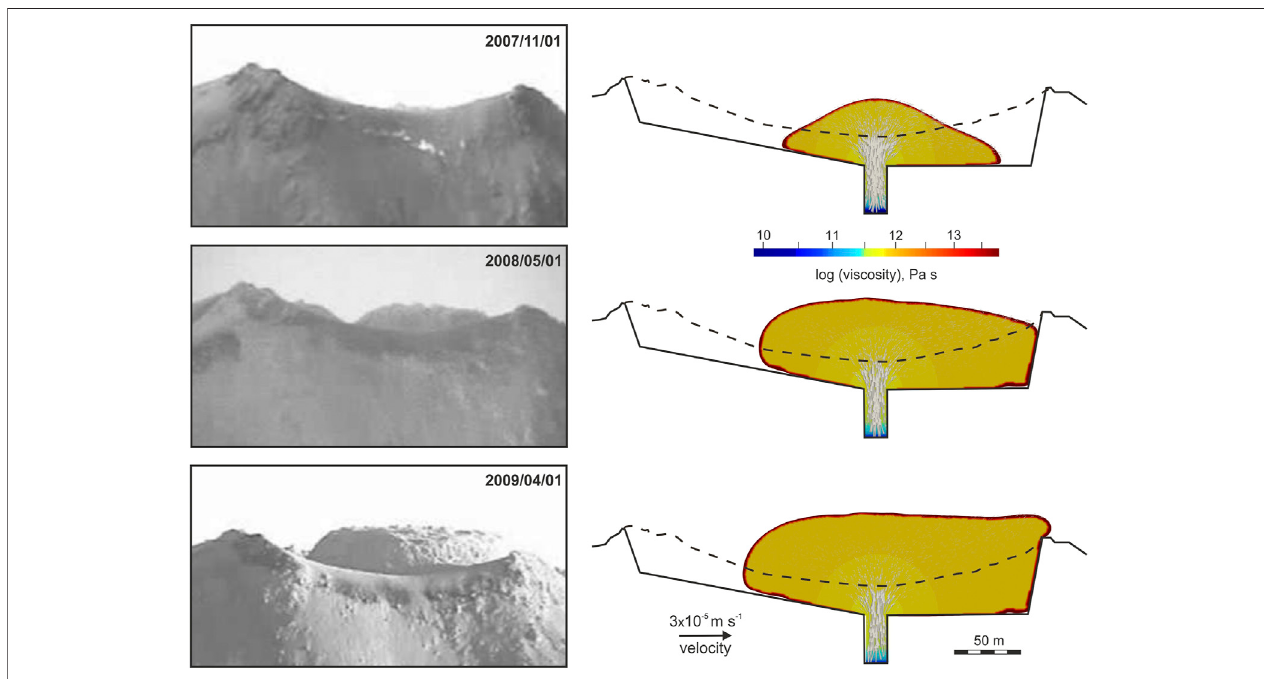
FIGURE 12 | The lava dome morphology at Volcán de Colima ( left panels ; images from Bretón-González et al., 2013) and the modeled viscosity and velocity (arrows) in exp. 10 (right column) at times of 2007/11/01 (upper panels) , 2008/05/01 (middle panels) , and 2009/04/01 (lower panels) .